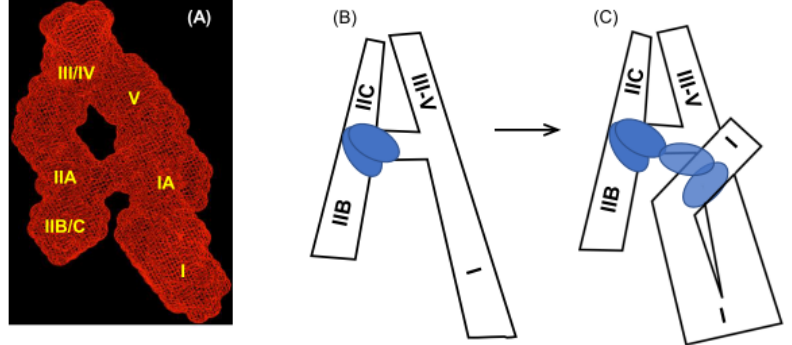
Conformational flexibility of HIV-1 RRE SL-I contributes towards assembly of the Rev-mediated export complex. ( A ) Molecular envelope of the RRE RNA, drawn in mesh and derived by SAXS [32]. The spatial resolution of the envelope is 21 A ◦ . ( B ) Cartoon representation of the RRE, depicting assembly initiating via a single nucleation point in SL-II for two Rev molecules (blue). ( C ) Through an SL-I conformational change, “coupling” of SL-I and SL-II Rev-binding sites promote a tetrameric intermediate complex proposed to serve as a specificity checkpoint. Rev and the RRE could thereafter simultaneously sample a number of interaction conformations until an optimal binding state for Crm1 binding and nuclear export is attained.